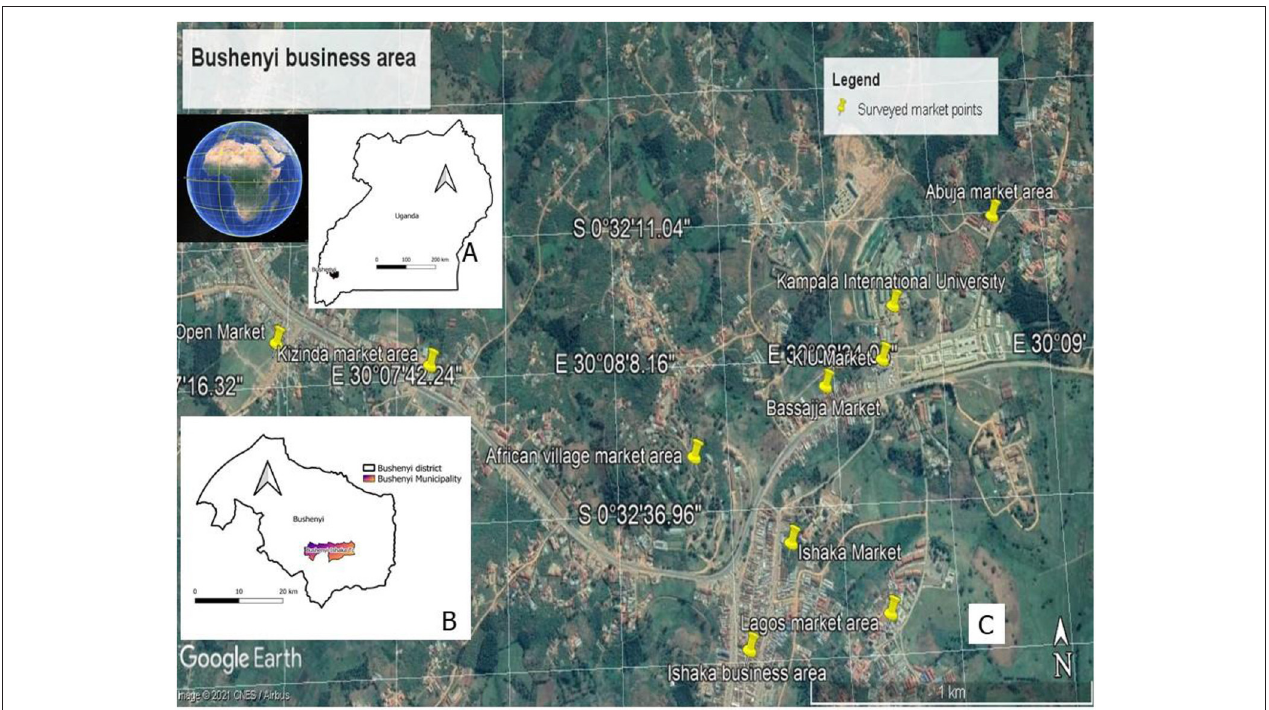
FIGURE 1 | Description of the study area. The study was conducted in Uganda (A) which is an East African country. In particular, the surveyed participants where located in Bushenyi Municipality (B) , covering a total of 10 market areas (C) . Market areas visited included: Kizinda market area, Kizinda open market, African village market area, Ishaka business area, Ishaka open market, Bassajja market, Kampala International University (KIU), KIU open market, Lagos market area, and Abuja market areas (C)